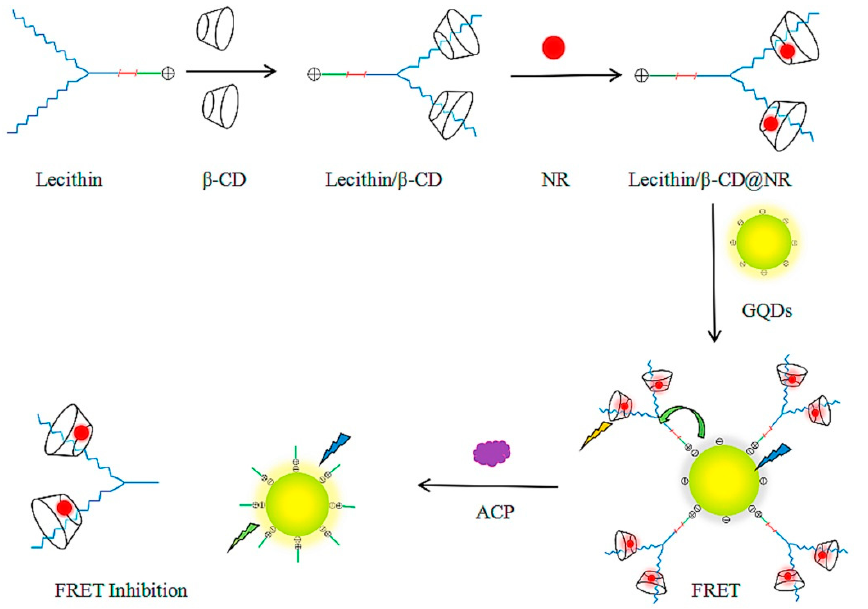
Figure 8. Illustration of the optical biosensor for the detection of ACP based on FRET between donor GQDs and acceptor Nile Red. Reprinted from ref. [173]. Copyright (2016) with permission from Elsevier.